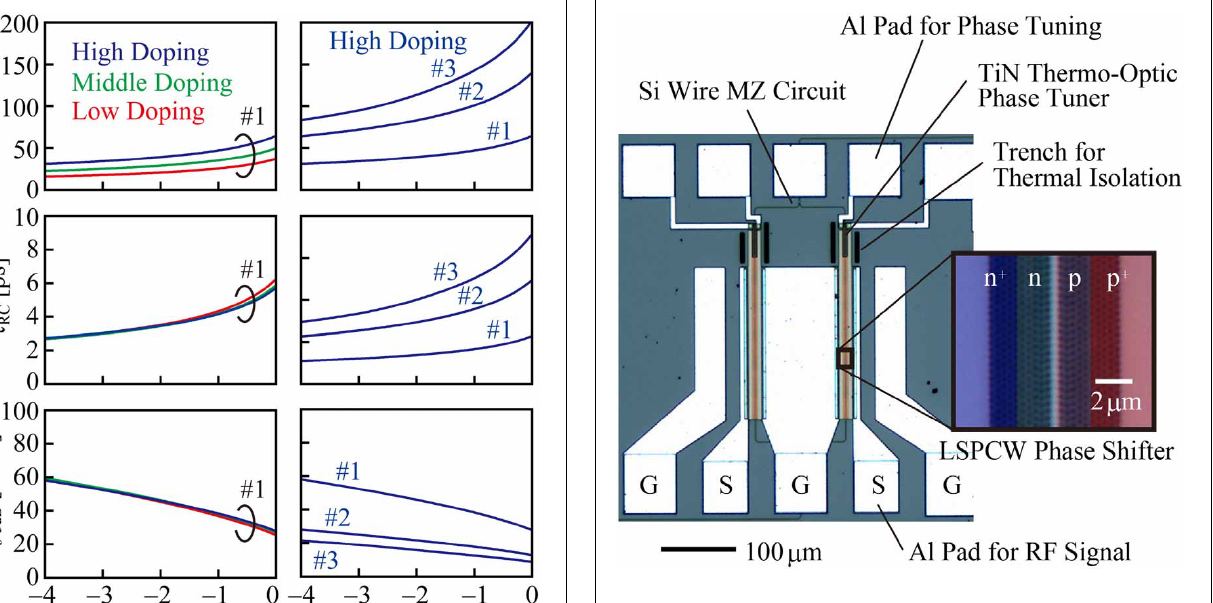
FIGURE 7 | Optical micrograph of fabricated device.